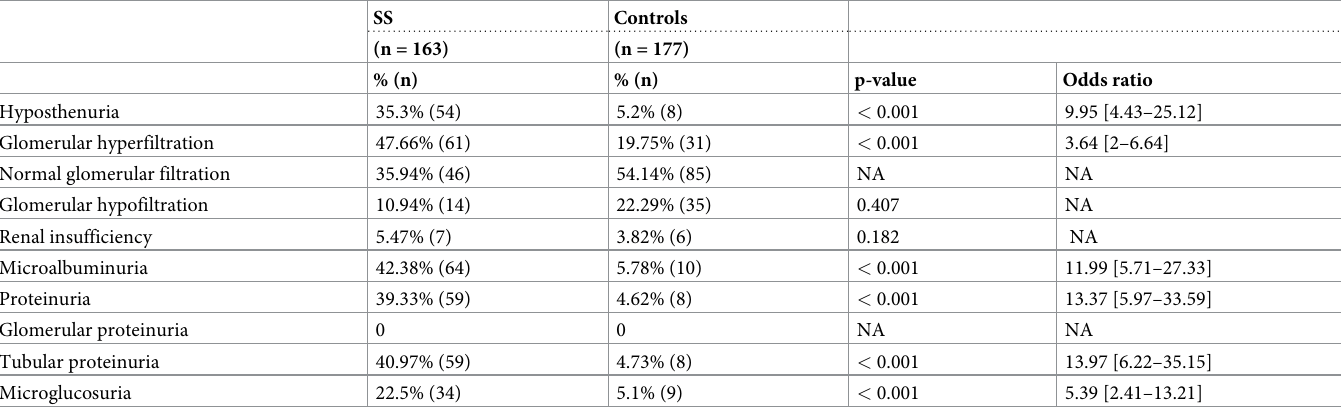
Table 4. Comparison of disturbances of nephropathy biomarkers between sickle cell anemia patients and controls. SS